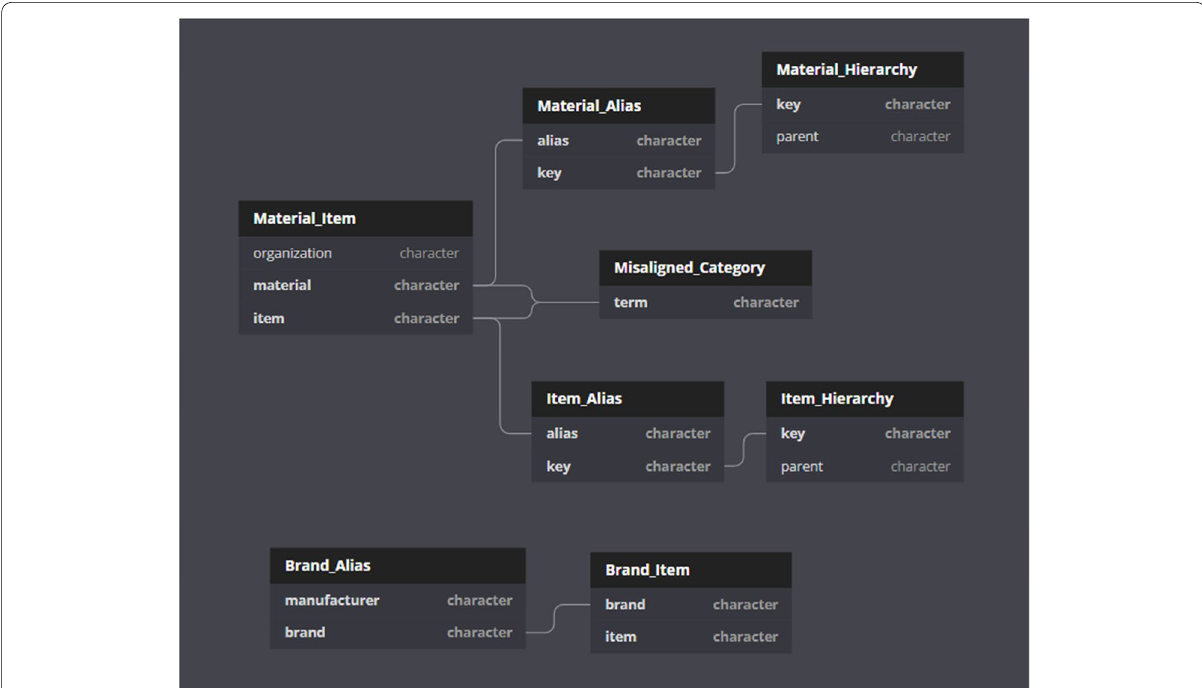
Fig. 2 Visual representation of relational tables and how they can be linked. Figure created with DB Diagram. This database can be accessed in an interactive version at https:// dbdia gram. io/d/ 5f3d9 342cf 48a14 1ff55 7dfe where there is detailed information about each feature. Each box is a relational table. The rows are the column names in the table, followed by the information type (all are character type (i.e., text)). The lines show columns that are precisely equivalent in meaning and